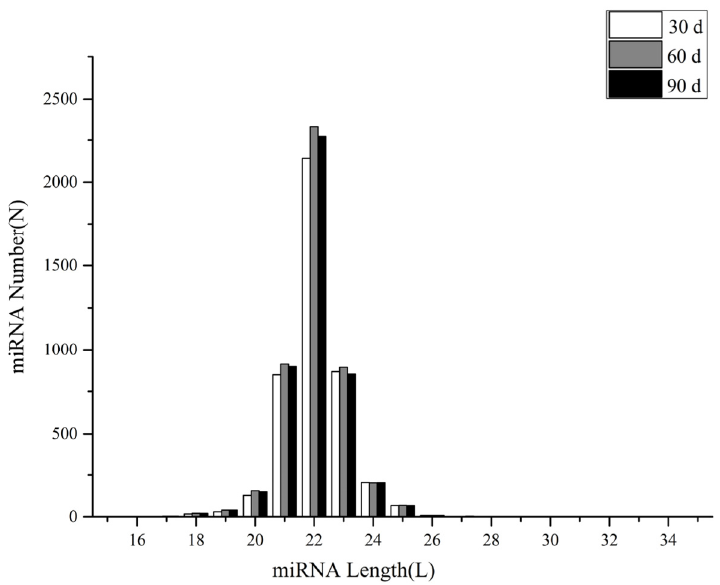
Figure 1. Length distribution of all identified miRNAs. The sequence length of mature miRNA in most species is about 22 nt. The length distribution of miRNAs identified in this study was 18–27 nt, mainly ranging from 20 to 24 nt.